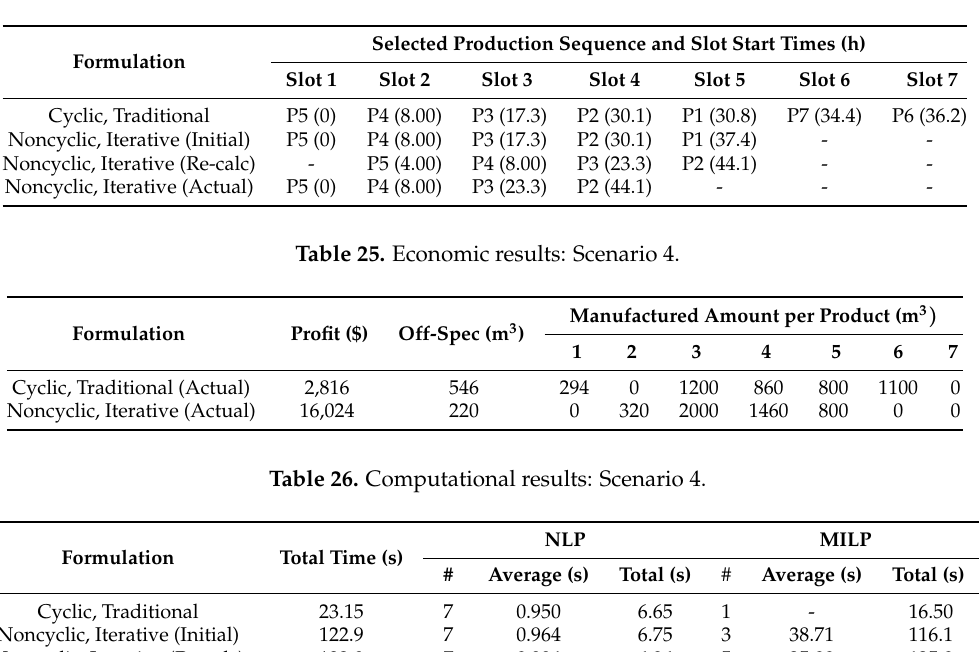
Table 24. Production schedule: Scenario 4.